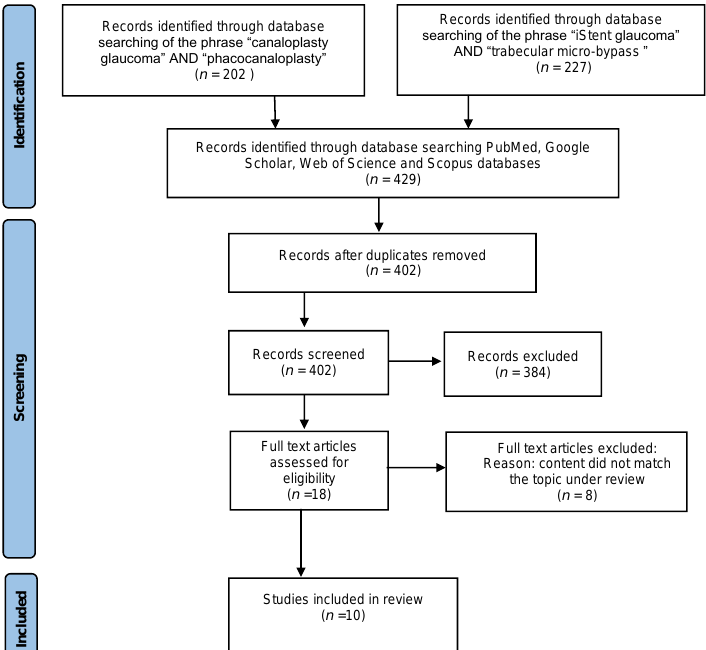
Figure 1. PRISMA flowchart of study selection process. Table 1. Characteristics of the prospective randomized control trials included in the analysis.